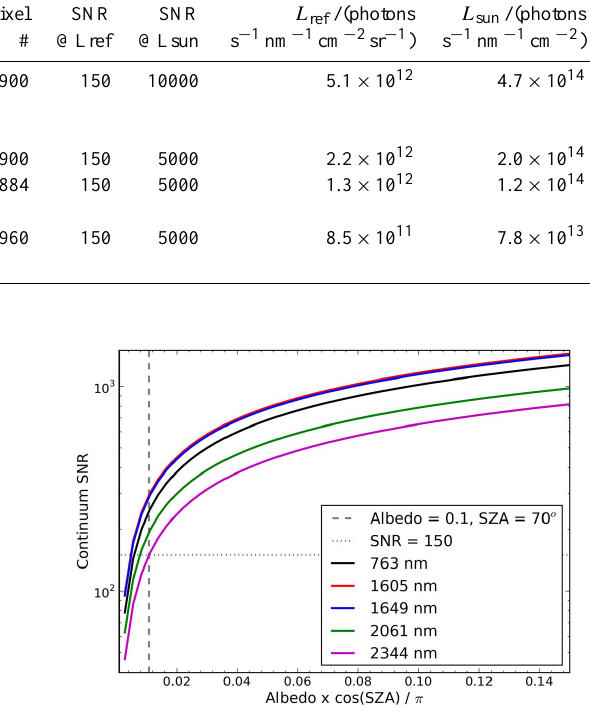
Figure 4. Signal-to-noise ratio (SNR) in the continuum of the backscattered radiance vs. scene brightness for various wavelengths (see legend). Scene brightness is given by albedo × cos ( SZA )/π , i.e. the reflectance of a transparent atmosphere above a Lambertian